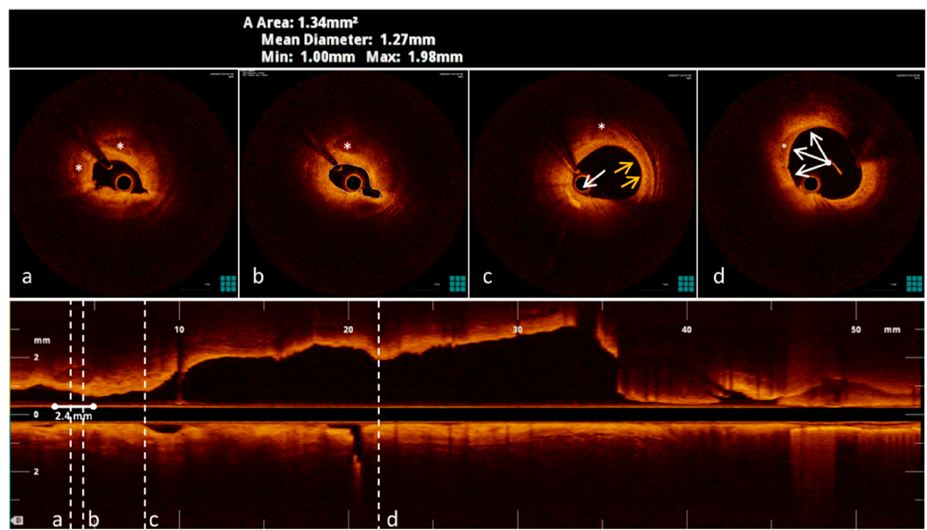
Figure 4. OCT overcomes angiography limits during an acute coronary syndrome with transient ST-elevation in a symptomatic patient. This is a clinical case that can well show plaque activity in an Acute Coronary Syndrome (ACS). A 66-year-old man, smoker, hypertensive, presented chest pain at Emergency Department. The EKG showed a transient inferior ST-elevation associated at high-sensitive Troponin increased. An early ( < 2 h) coronary angiography was performed but, no significant lesions were detected ( A – C ). Optical Coherence Tomography (OCT) was executed and a severe spasm occurred immediately after guide-wire crossed the lesion ( D , black arrow). Nitroglycerine administration did not reverse the intense spasm and the intravascular imaging show a very tight lesion with a minimum lumen area of 1.34 mmq (cross section “ b ”). In the atheroma two spotty calcifications (cross section “ a ” and “ b ”, white asterisks) and, proximally, activated macrophages (cross section “ c ”, white arrow), TCFA (yellow arrow) and lipid pool (white asterisk), were detected. Moreover, other two smaller and superficial calcifications (cross section “ d ”, white arrow and asterisk), forming, joined an arch ( < 90 ◦ ), were identified. A stent was placed and optimized, guided by OCT features, reaching a good angiography result ( E and F